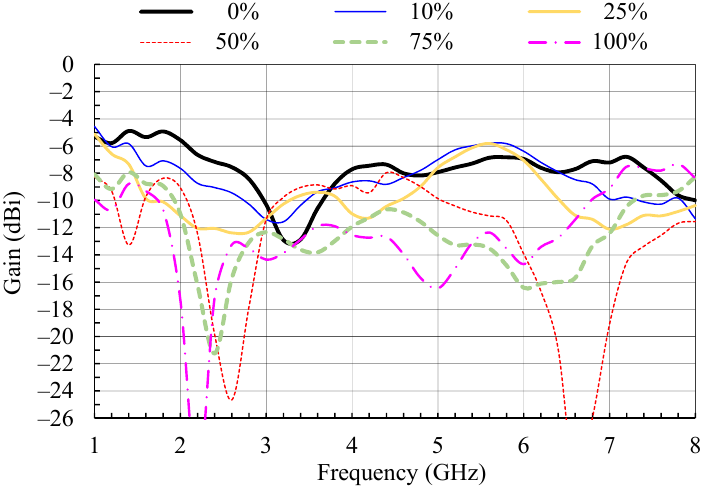
Figure 9. Measured gain of the wideband textile monopole for different moisture contents [14].